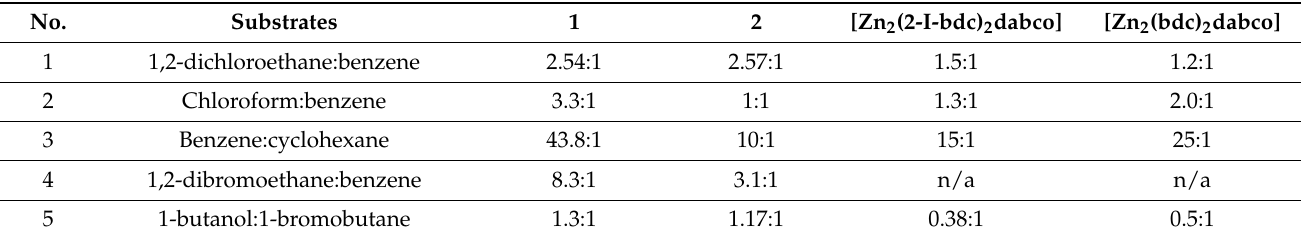
Table 1. Selectivity of vapor adsorption by 1 , 2, [Zn 2 (2-I-bdc) 2 dabco] and [Zn 2 (bdc) 2 dabco] [62] from equimolar mixtures of different organic